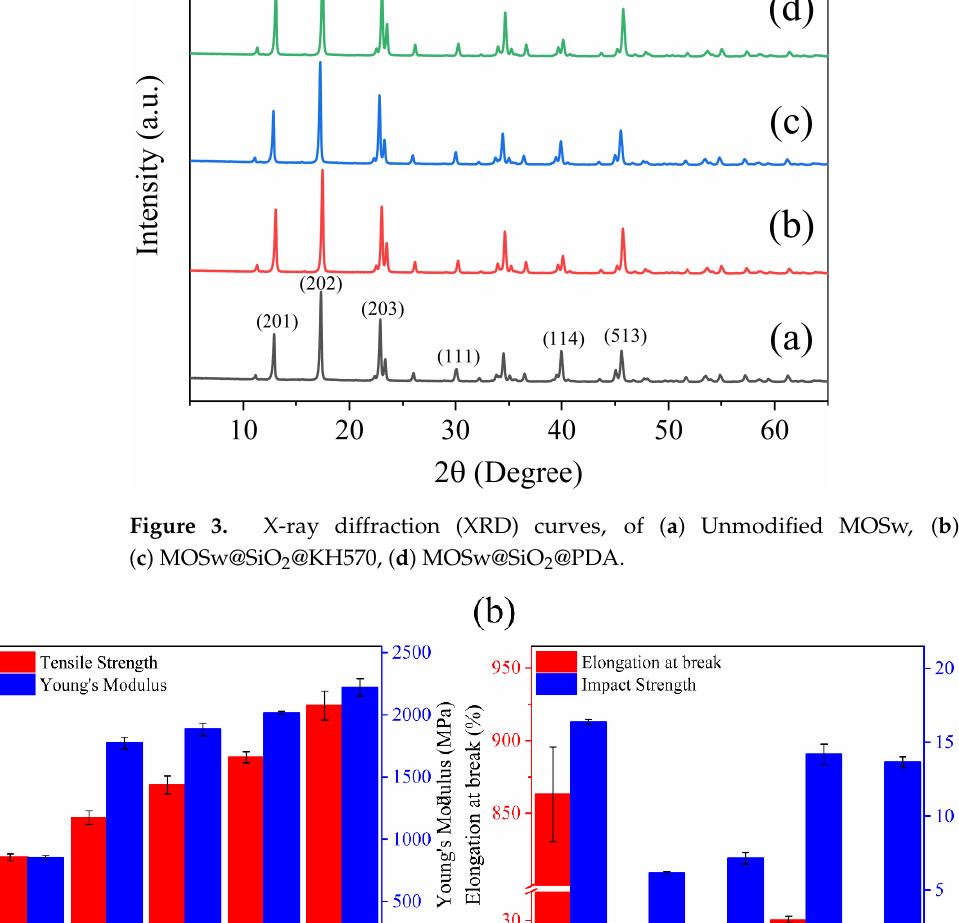
Figure 3. X-ray diffraction (XRD) curves, of ( a ) Unmodified MOSw, ( b ) MOSw@SiO 2 , ( c ) MOSw@SiO 2 @KH570, ( d ) MOSw@SiO 2 @PDA.